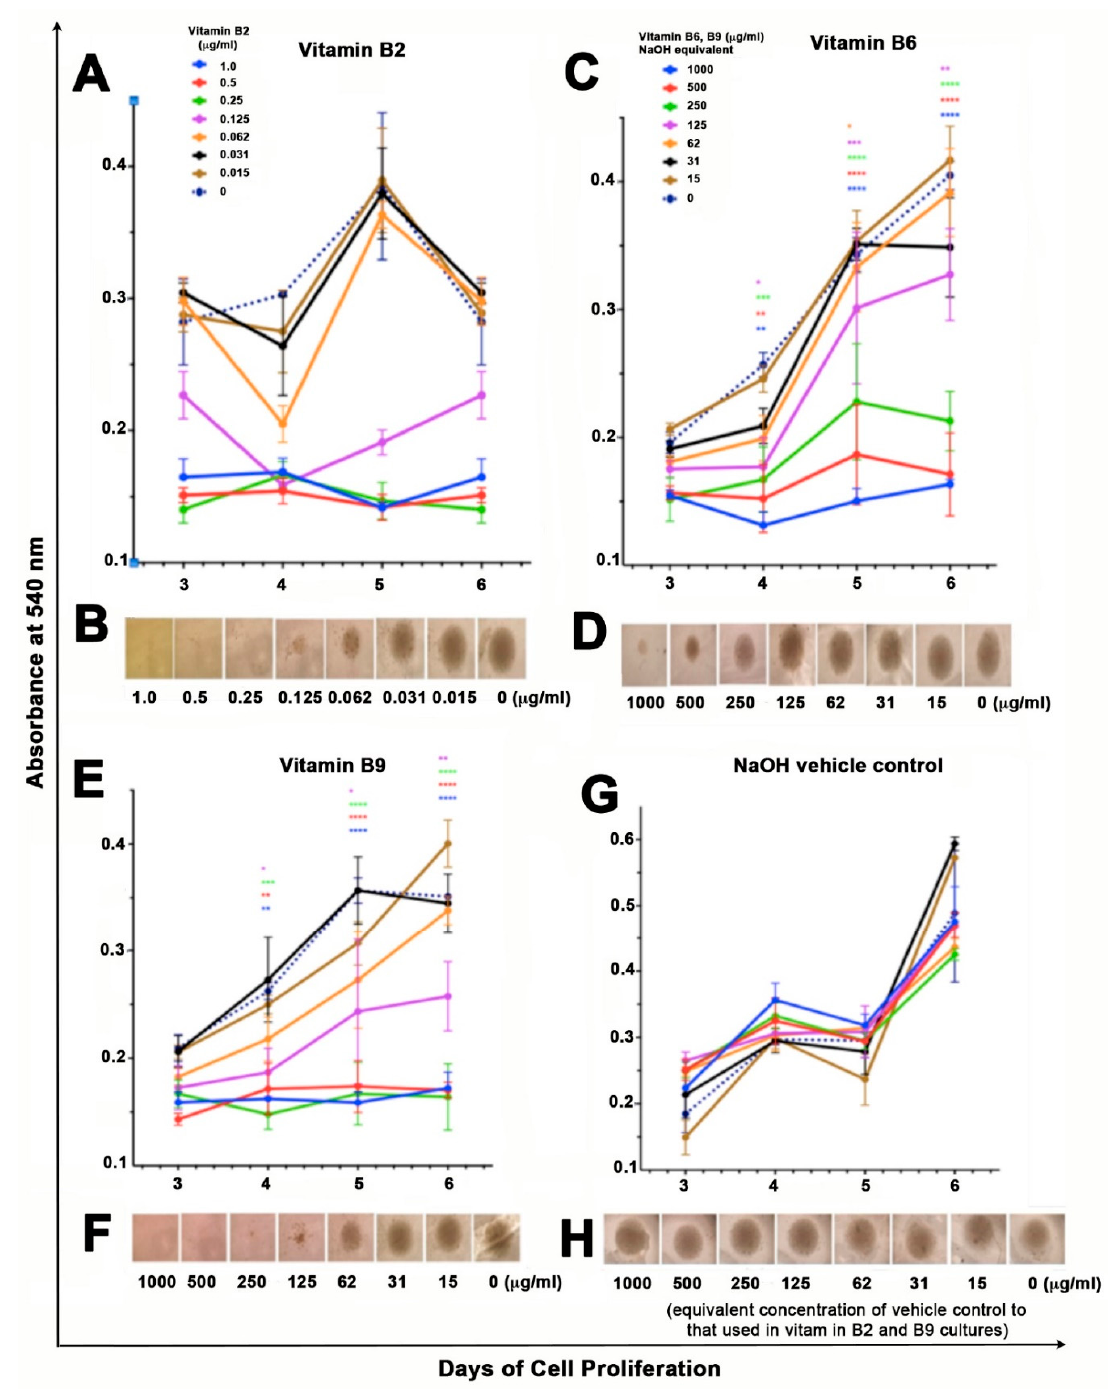
Figure 1. ( A,B ), E ff ect of vitamin B2 (riboflavin) ( C,D ), vitamin B6 (pyridoxine) ( E,F ), vitamin B9 (folic acid) (G,H) , NaOH control on U937 cell proliferation. Cells were incubated with increasing doses of vitamin B for 6 days in 96 well U bottom plates and analyzed by MTT assay. Absorbance readings were taken at 540 nm to assess for cellular proliferation compared to control well (0 µ g / mL). Significance was established at p , 0.05, two-way analysis of variance (ANOVA) followed by Tukey’s multiple comparisons test and marked with asterisk (* p < 0.05, ** p < 0.01, *** p < 0.001, **** p < 0.0001). Cells were viewed under an IX81 Olympus microscope at 4x magnification and photos taken at each concentration and control NaOH on day 6 of culture.